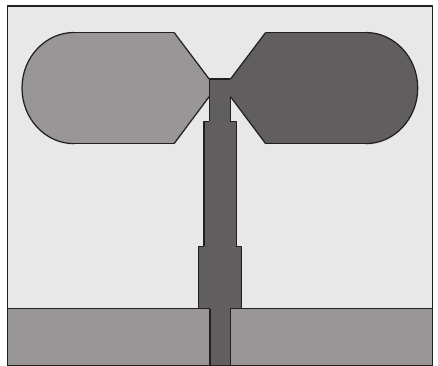
Figure 29: A printed double-sided rounded bow-tie antenna (DSRBA) [94]. Dark gray upper metal face, medium gray bottom metal face, and light gray dielectric